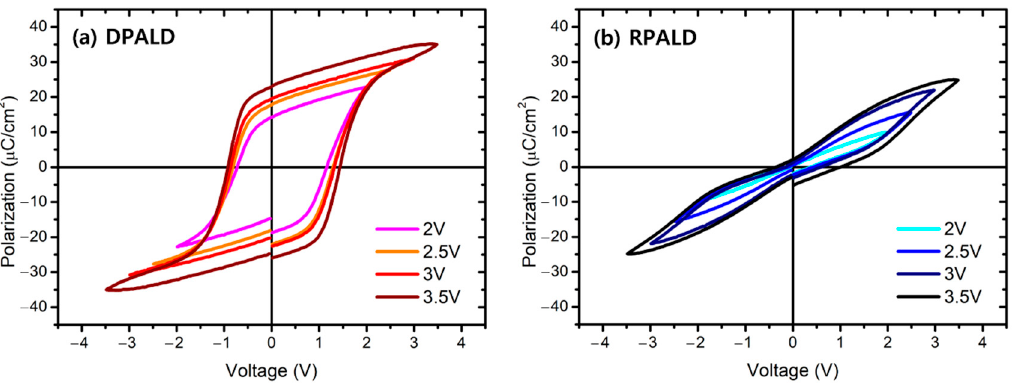
Figure 7. P–E hysteresis loop curves of the HZO thin films deposited by the ( a ) DPALD and ( b ) RPALD methods, according to the measurement voltage after 10 5 cycles.